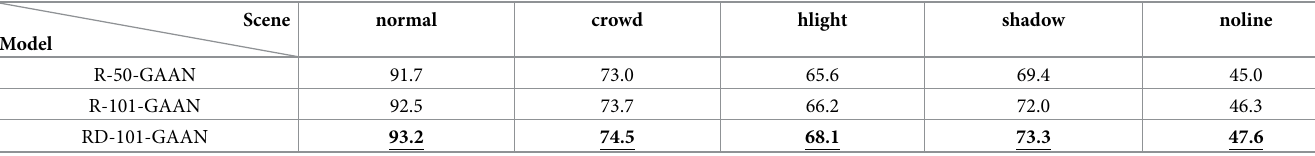
Table 6. Ablation experiments of GAAN with different backbone.